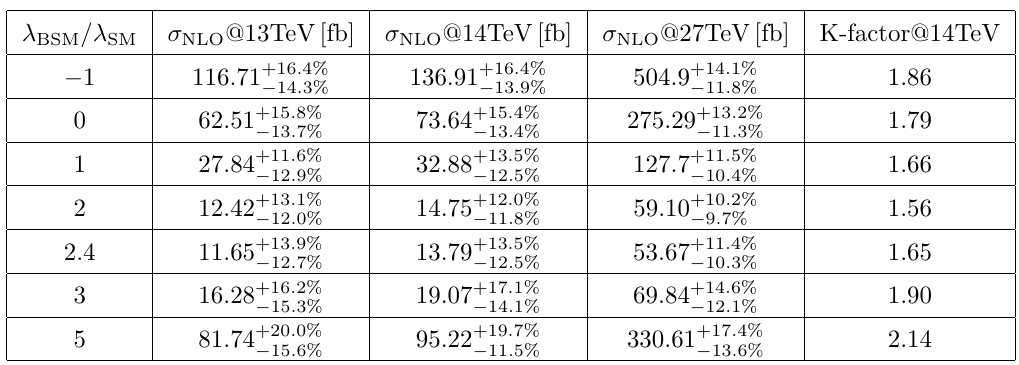
Table 1. Total cross sections for Higgs boson pair production at full NLO QCD. The given uncertainties are scale uncertainties.